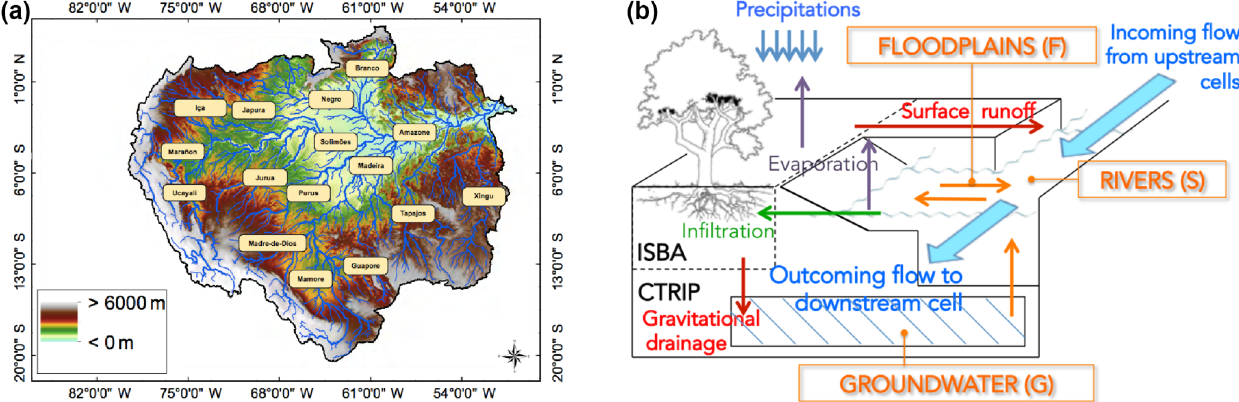
Figure 1. (a) The Amazon basin main tributaries and rivers with the underlying topography from SRTM. (b) Schematic representation of the ISBA-CTRIP system for a given grid cell. ISBA surface runoff ( Q ISBA , sur ) flows into the river/surface reservoir S ; ISBA gravitational drainage ( Q ISBA , sub ) feeds the groundwater reservoir G . The surface water is transferred from one cell to another following the TRIP river routing